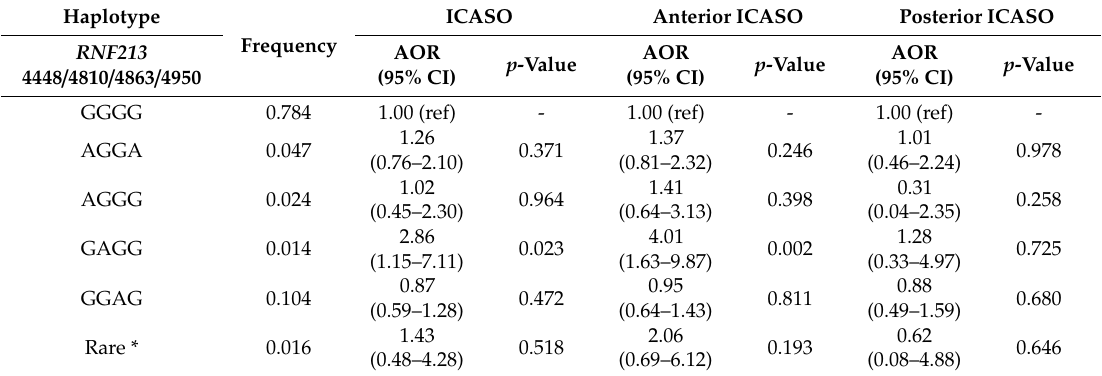
Table 5. Haplotype analysis of RNF213 variants for the presence of